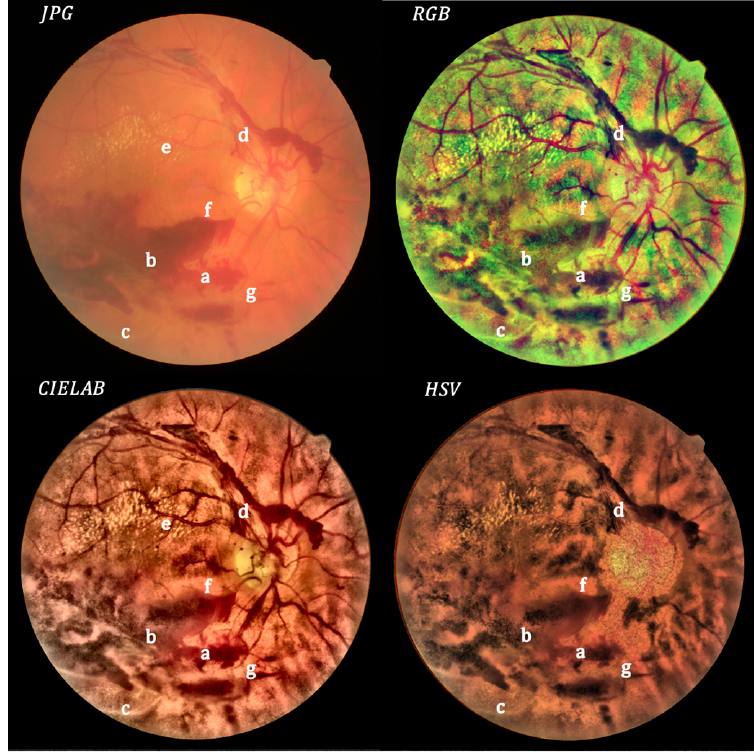
Figure 5. Non-cataract: original (upper left) and processed images.